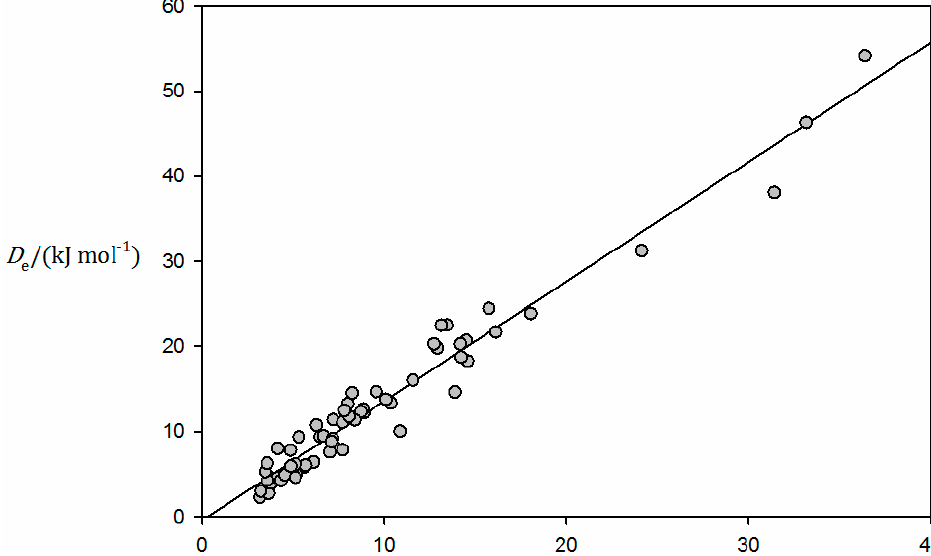
Figure 8. Plot of D e calculated at the CCSD(T)/CBS level versus k σ calculated at the CCSD(T)/aug-cc- pVTZ level for B ⋯ CO 2 , B ⋯ N 2 O, and B ⋯ CS 2 complexes (this work; see also Figure 7), and B ⋯ HF, B ⋯ HCl, B ⋯ F 2 , B ⋯ Cl 2 , and B ⋯ ClF complexes (see Reference [32] for the Lewis bases B involved and the values of D e and k σ for the B ⋯ HX and B ⋯ XY series).